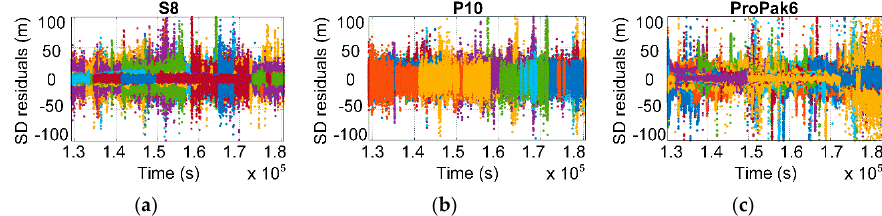
Figure 7. Station single-difference pseudorange residuals of all observed satellites in static data collected by smartphone S8 ( a ), smartphone P10 ( b ), and geodetic devices ProPak6 ( c ), respectively. Different colors correspond to different